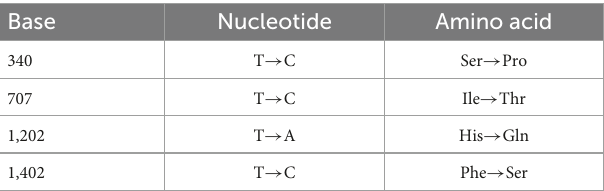
TABLE 3 Base and amino acid mutation sites of the HA gene in a Patchouli alcohol-resistant influenza strain. Base